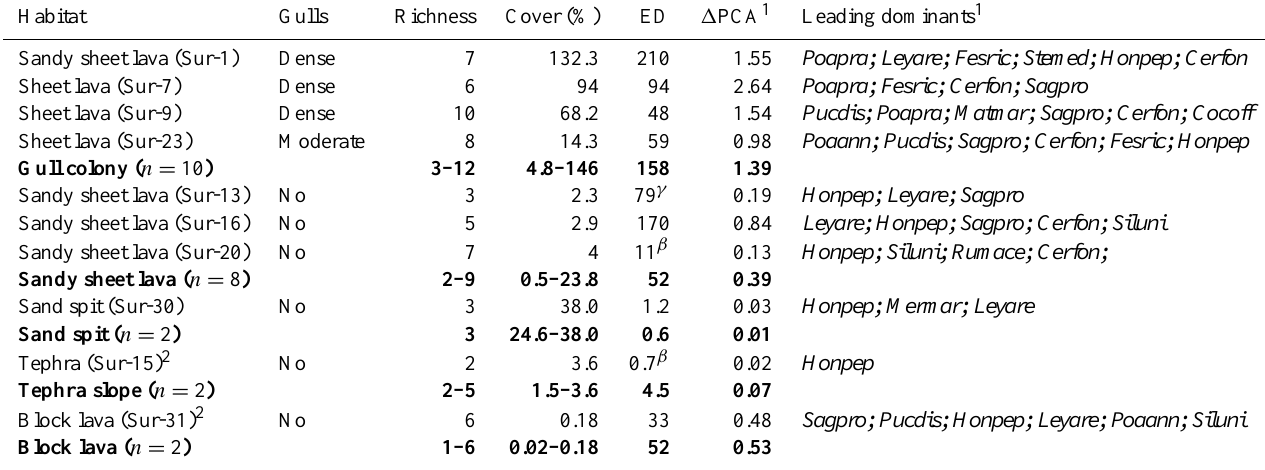
Table 2. Characteristics of selected sample plots on Surtsey. Richness and cover were recorded in 2012. Group richness range is the range of maximum richness. ED is the Euclidean distance of the trajectory; 1 PCA is change in PCA-1 scores that summarize the DCA analysis; significant linear regressions indicated as follows: α = P < 0 . 05; β = P < 0 . 01; γ = < 0 . 001.